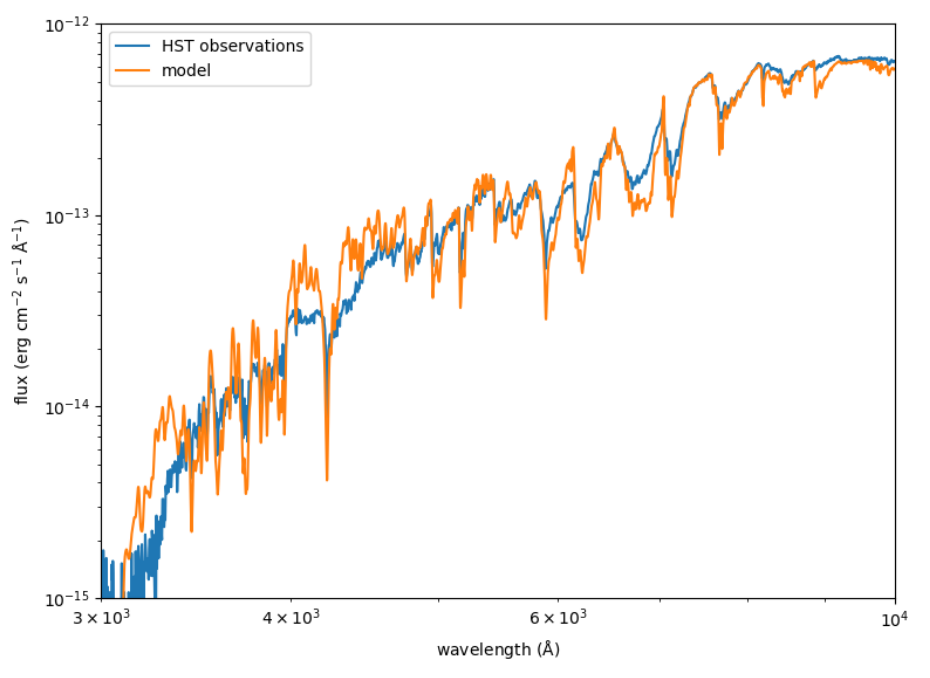
Figure 6. Observed (blue) and model (orange) spectra for the M-type dwarf star GJ 555. The model has been scaled using the estimated stellar radius from [35] and the Gaia DR3 parallax for the